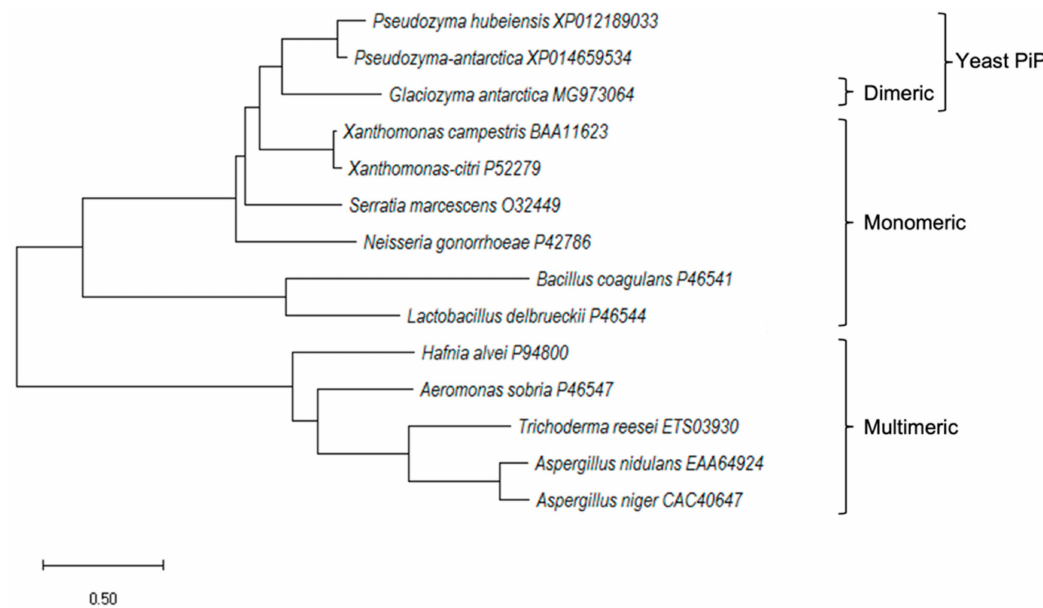
Figure 2. Phylogenetic analyses of proline iminopeptidases from different microorganisms. The phylogenetic tree was constructed using MEGAX software [24].